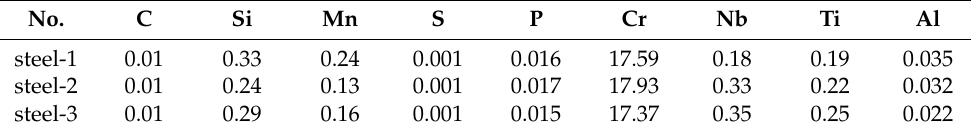
Table 1. Chemical composition of 439 ferritic stainless steels